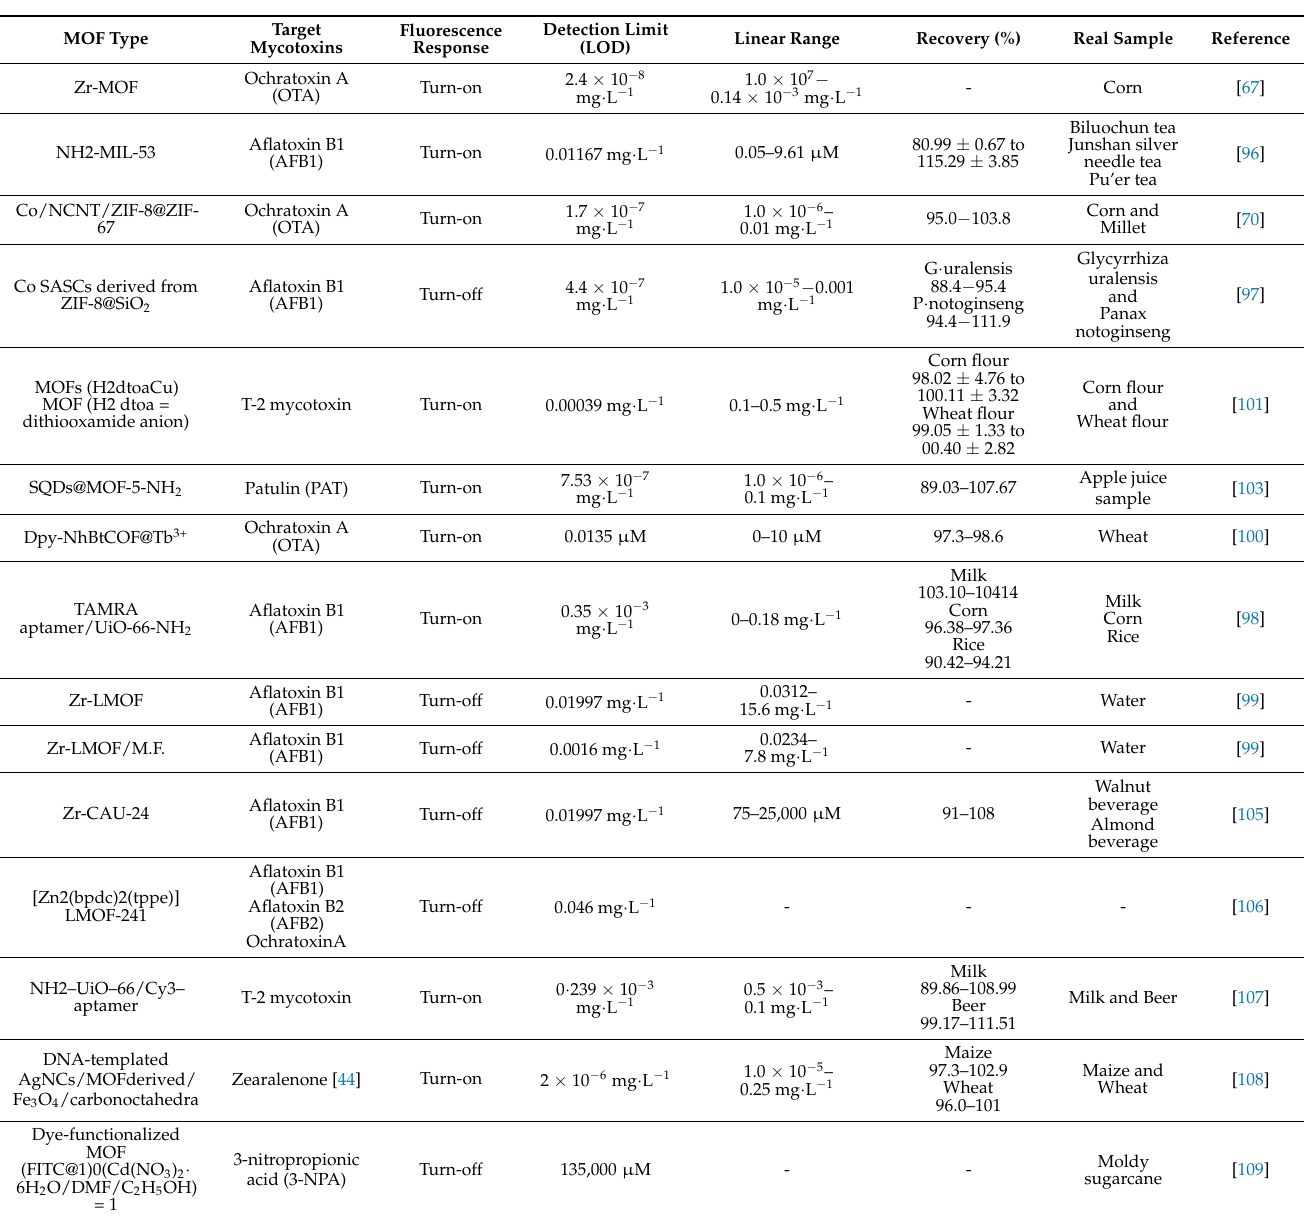
Table 2. Recent advances in optical-based sensing platforms to detect various mycotoxins in numer- ous food